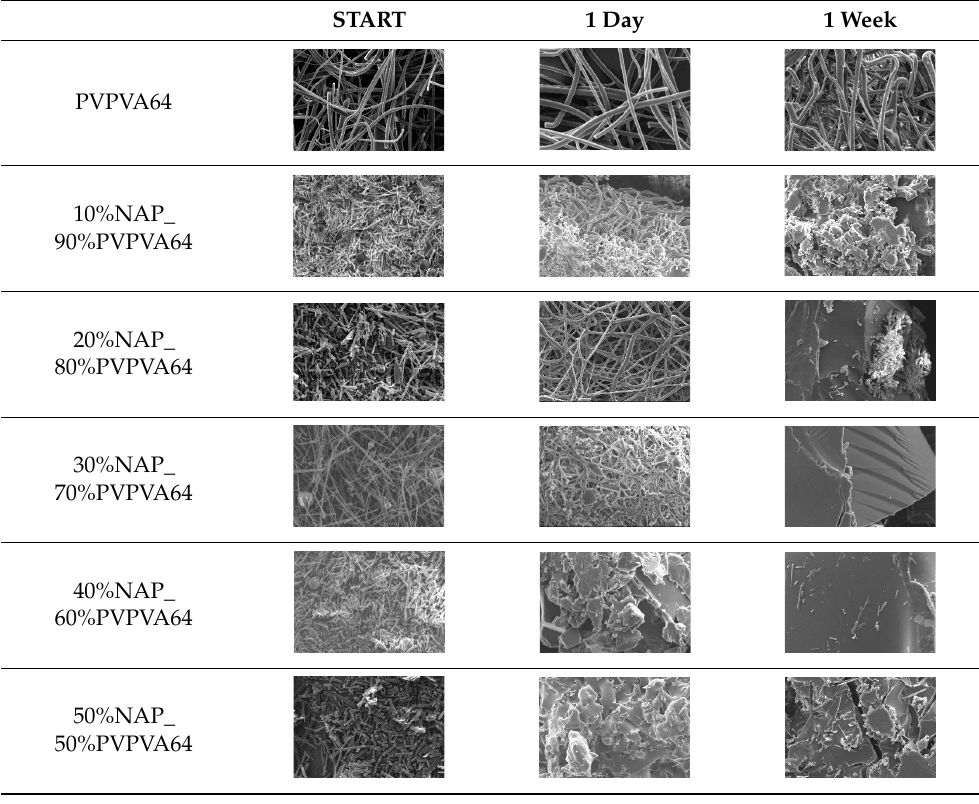
Table 3. Summary of the SEM images of the prepared samples before and after storage.